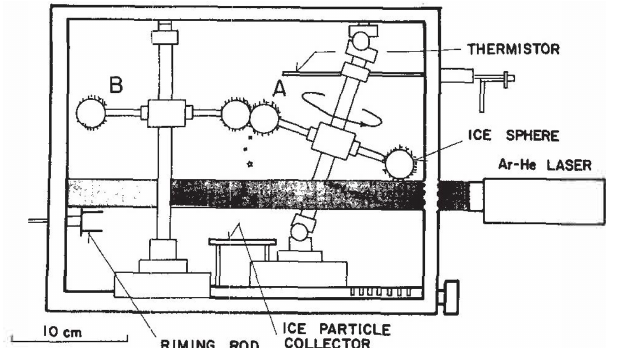
Figure 2. Experimental apparatus of Takahashi et al. (1995), used to observe fragmentation in ice–ice collisions. In (A), ice spheres rotated at a tangential speed of 4ms − 1 , while, in (B), ice spheres were stationary. The ejected ice particles were collected on the plate below. Cloud droplets were supplied from the centre of the right wall. Source: Takahashi et al. (1995). © American Meteorological Society. Used with